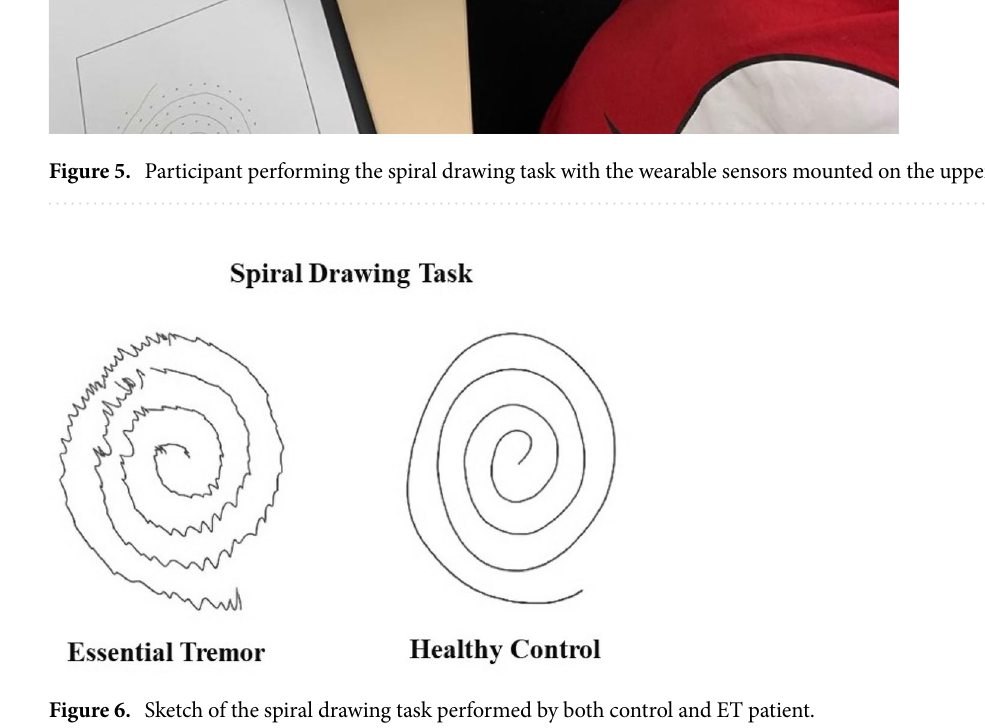
Figure 6. Sketch of the spiral drawing task performed by both control and ET